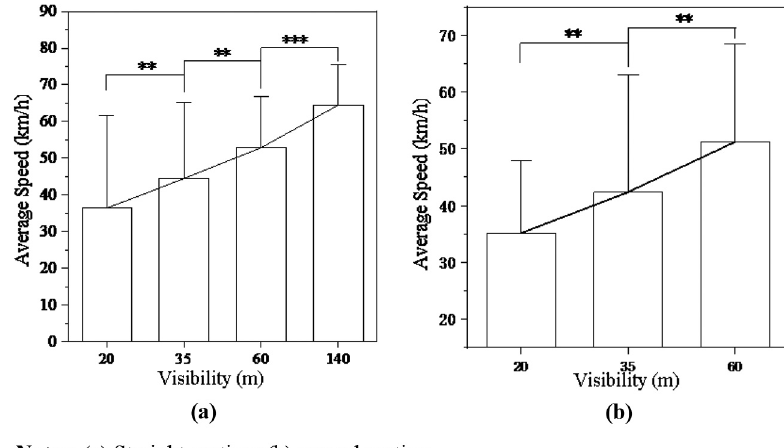
Figure 4 Average speed of different visibility conditions at straight section and curved